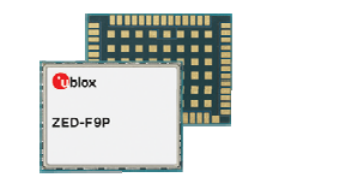
Figure 2 : ZED-F9 GNSS chip (17 x 22 x 2 mm)